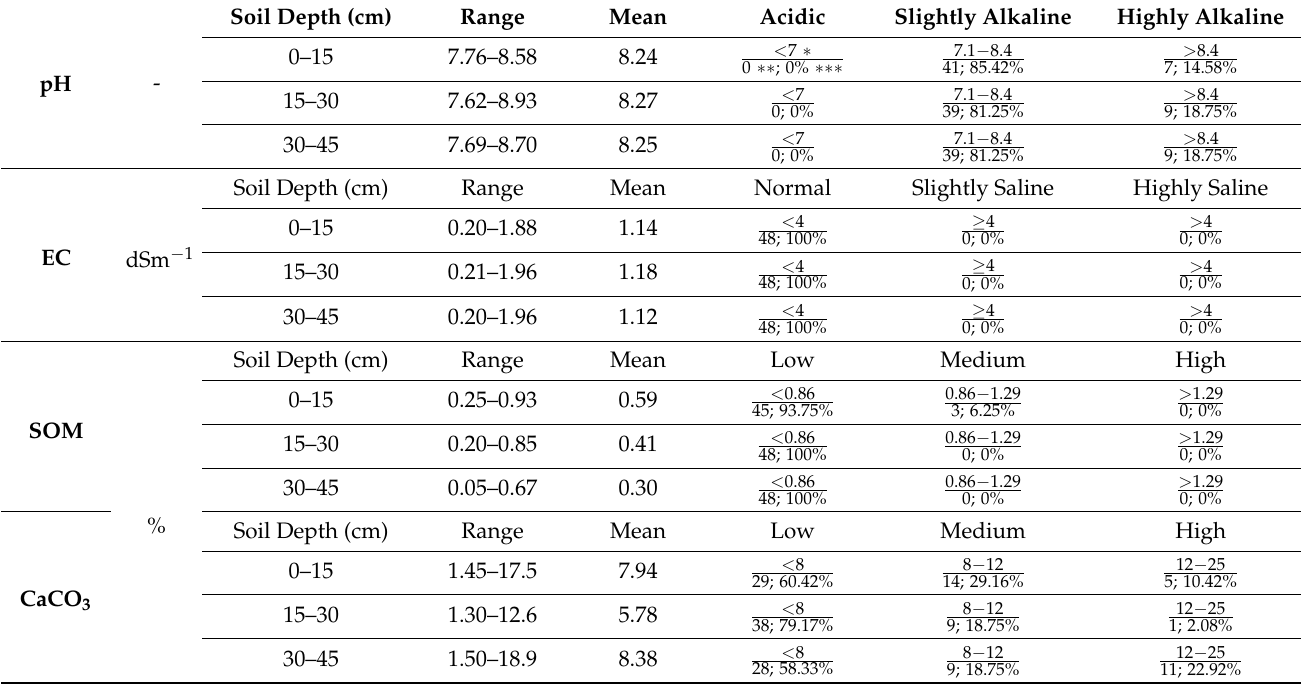
Table 2. Summary of selected physico-chemical properties of soils of citrus orchards in Layyah district. There were 48 sites at which sampling was performed. Means are an average of 3